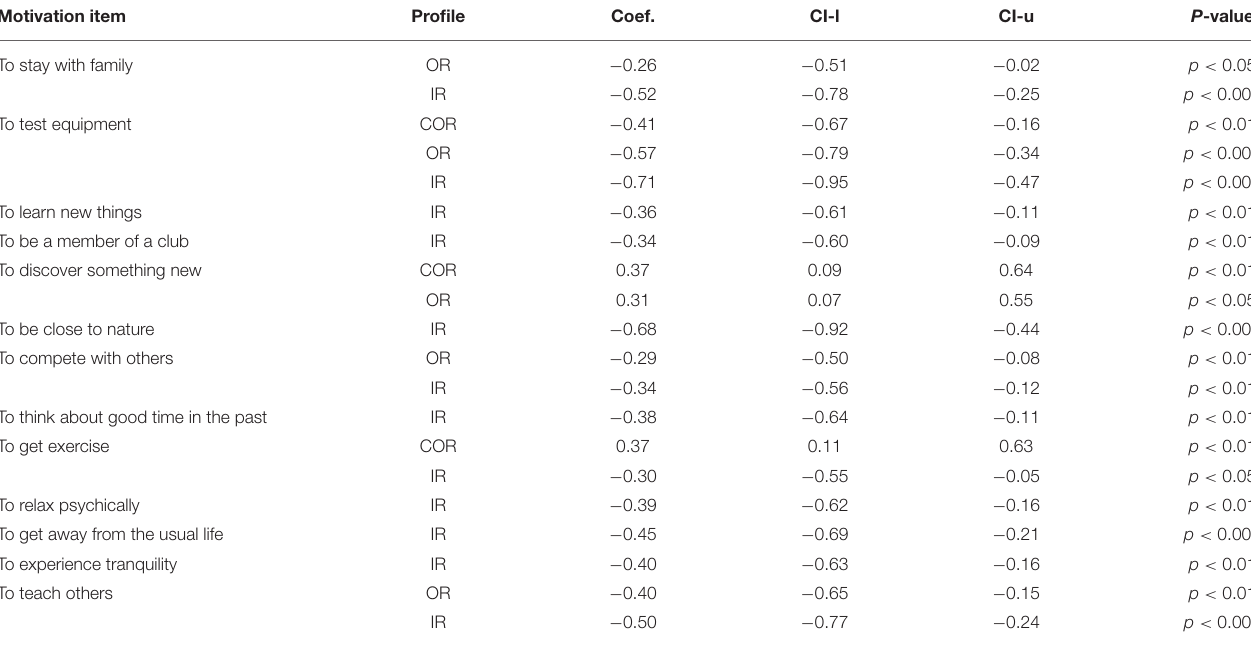
TABLE 3 | Parameters of the General Lineal Models (GLM) fitted to each motivation item and for each outdoor and indoor profile: Recreational Fishing (RF), Consumptive Outdoor Recreation (COR), Outdoor Recreation (OR) and Indoor Recreation (IR). Motivation